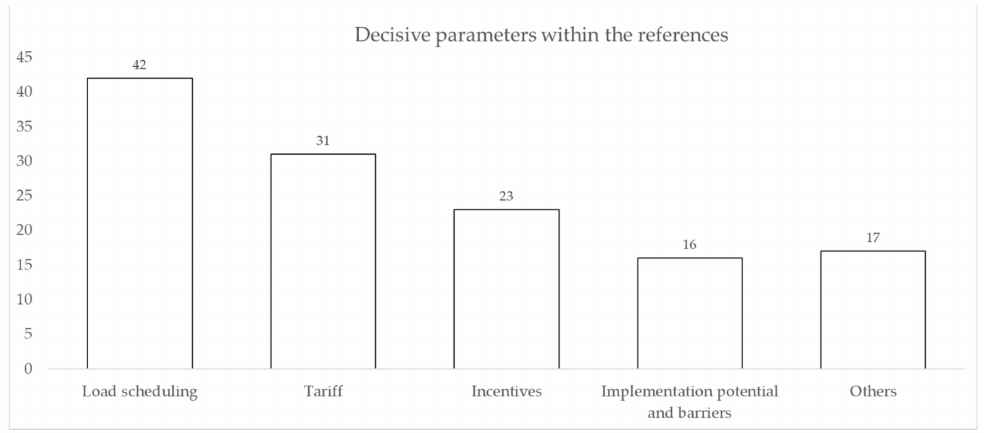
Figure 2. Distribution of decisive parameters within the